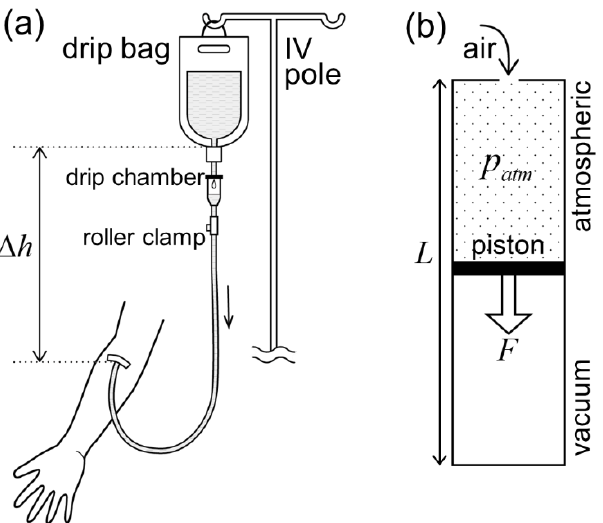
Figure 1. Gravity versus atmospheric pressure as a driving force for drip infusion. ( a ) An IV drip bag hung from an IV pole at a constant height, ∆ h , from a drip point on the arm maintains a constant infusion pressure to overcome the venous pressure. ( b ) Vacuum piston cylinder. A piston, with a cross-sectional area, a , separating a sealed vacuum chamber and an open chamber under atmospheric pressure, p atm , moves towards the closed end of the cylinder. The larger the diameter, d , of the piston (cross-sectional area a = π d 2 /4), the larger the magnitude of the driving force, F = p atm a , on the piston. The length of the cylinder, L , determines the moving stroke of the piston.